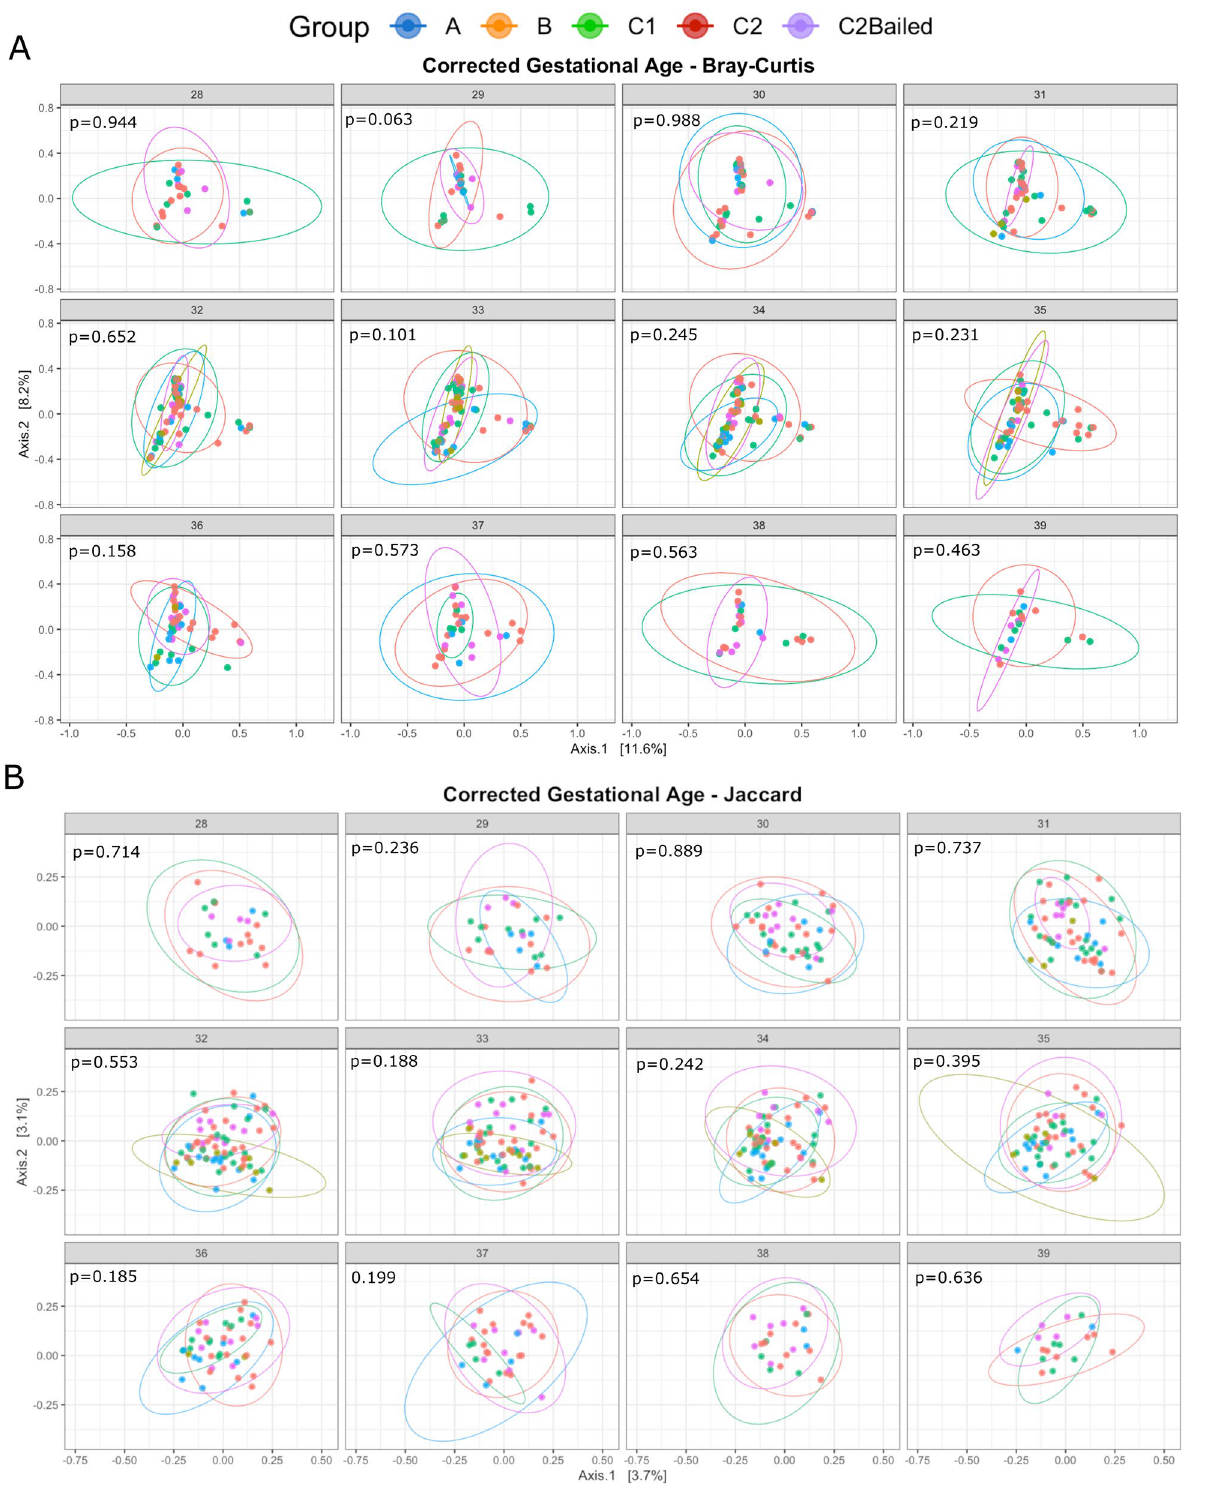
Figure 2. Antibiotic use explains little effect on beta diversity. PCoA ordination of stool samples using the ( A ) abundance-based Bray–Curtis and ( B ) presence/absence-based Jaccard distance metric among enrollment groups of corrected GA between 28–39. Ellipses are calculated based on a 95% confidence interval of a multivariate